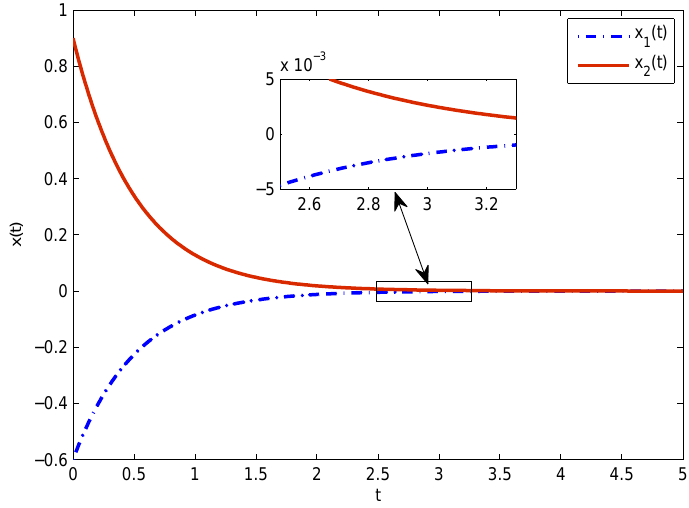
Figure 3. The state trajectories under controllers u 1 ( t ) and u 2 ( t )